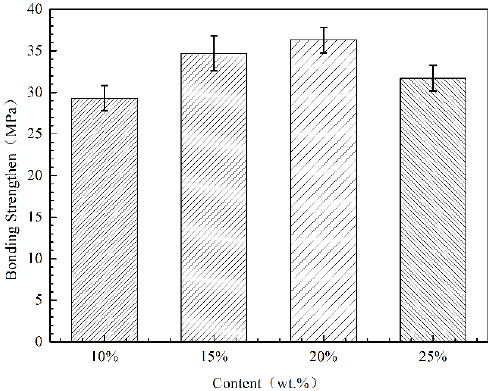
Figure 7. Influence of Ni content on the adhesion strength of coatings .